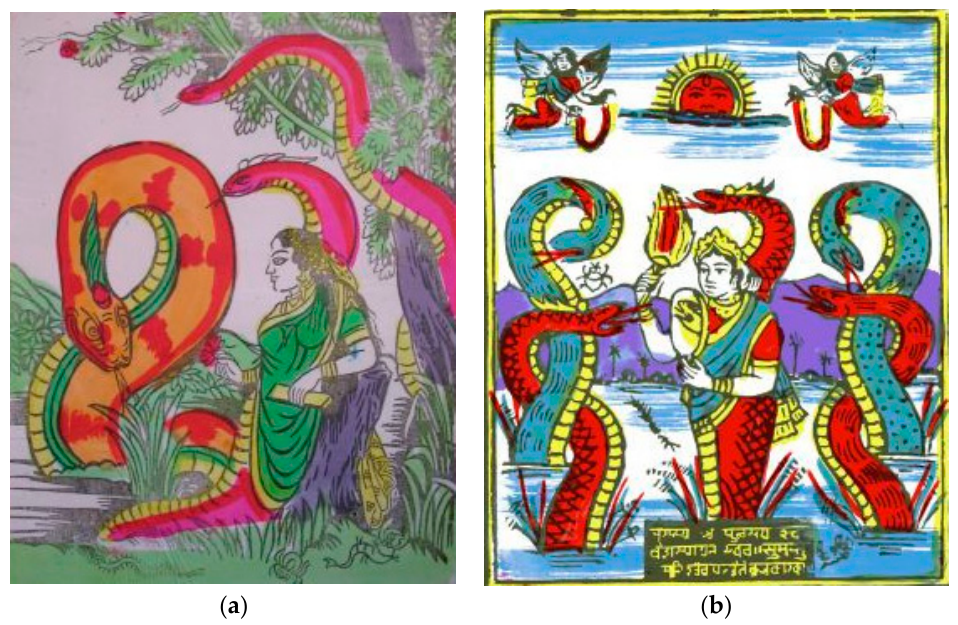
Figure 8. Two N ā g-kany ā s, “N ā ga-maidens”, conversing with or warding off snakes with ritual items; wood-printed and painted as votive or protective images (artist: P ā ine Thegana N ā r ā yan, Kathmandu 1994; both in the Marburg Museum of Religions): ( a ) N ā g-Kany ā holding a flower and a book (photo by Anne Beutter, acc.nr. B-Kp 155 011); ( b ) N ā g-Kany ā holding a fan and a mirror, possibly to ward off the evil eye or the hypnotic stare of snakes. The Sanskrit verse names five ancient sages, “Agastya, Pulasta, Vai ś amp ā yana, Sumantu and Jaimini, the five who resist the thunderbolt” 67 (photo by Anne Beutter, acc.nr. B-Kp 155 010).